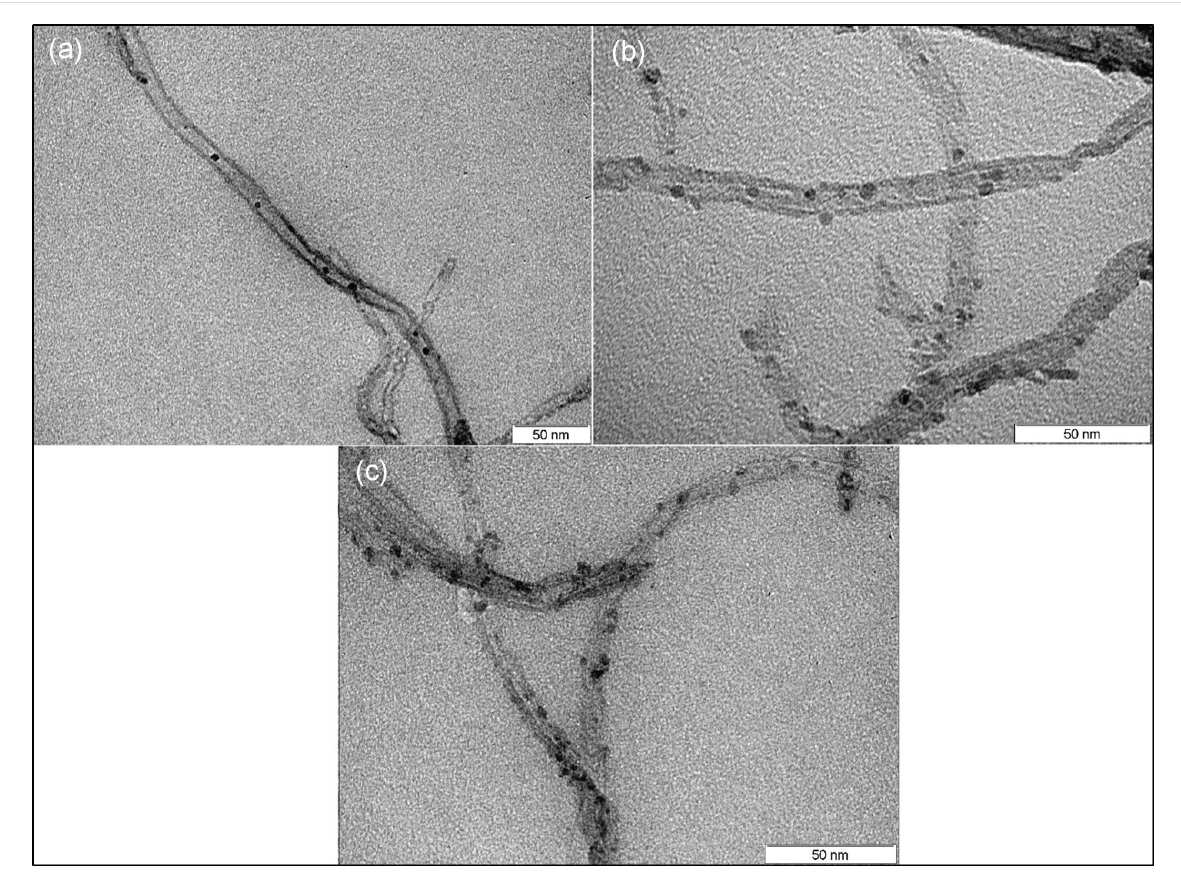
Figure 3: Different decoration densities for different decoration ratios of 1:1 (a), 1:1.3 (b) and 1:1.5 (c).